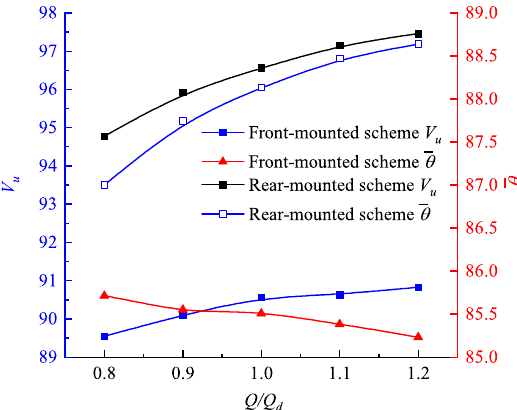
Figure 9. Velocity distribution of the impeller inlet section.